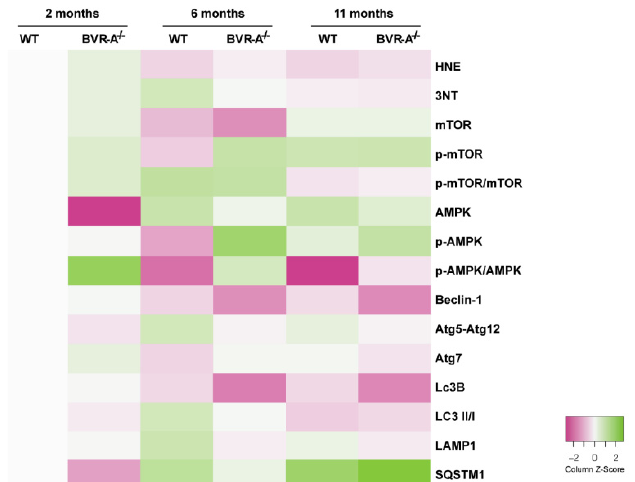
Figure 6. Heat-map showing changes for the proteins analyzed in the study. The heatmap shows a distribution pattern for all the proteins analyzed in the study across the groups of comparison, based on relative abundance (column z-score). The gray square indicates WT mice at 2 months of age set as 100% and used as normalization group. We set Pink / White / Green for our color scheme. Pink represents the lower values, white the middle and green the highest